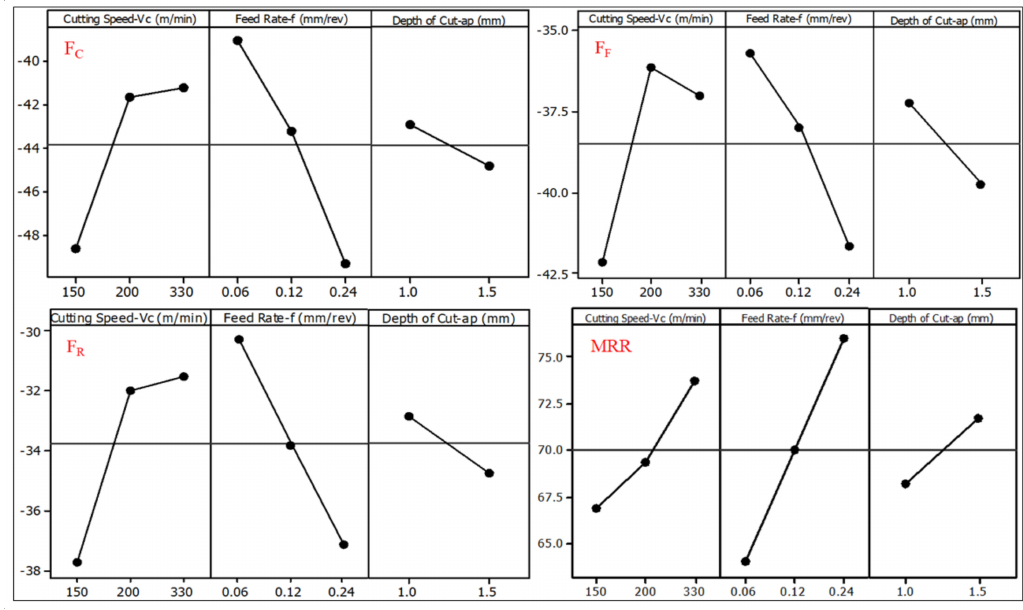
Figure 6. Optimal solutions for the response parameters according to the Taguchi